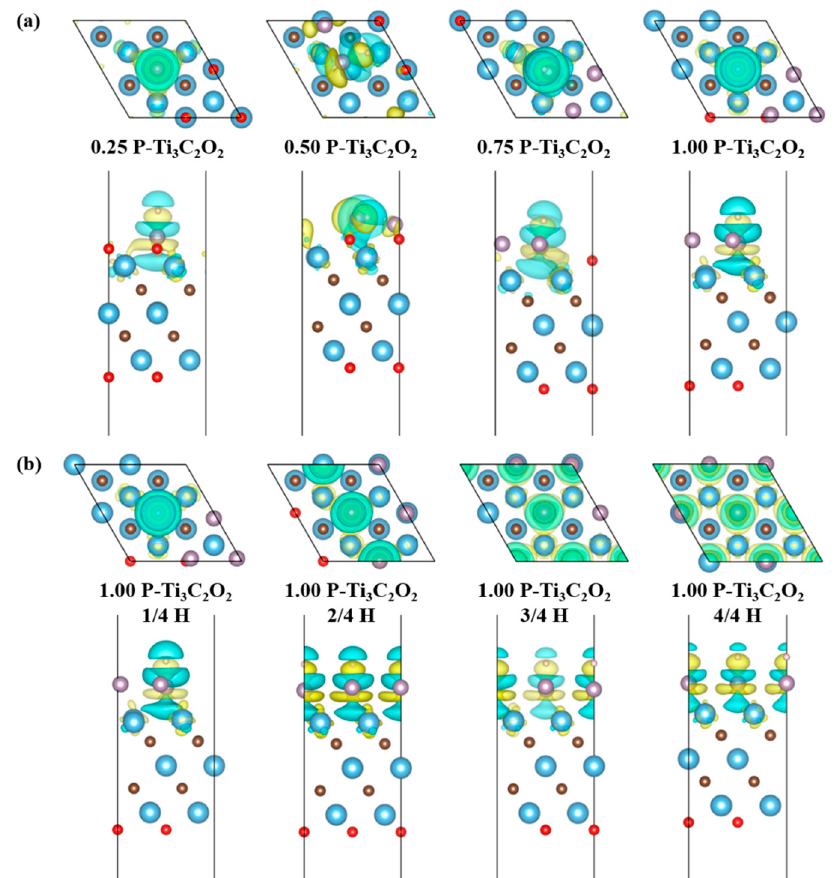
Figure 8. ( a ) The difference charge densities (DCD) of Ti 3 C 2 O 2 doping 0.25, 0.50, 0.75 and 1.00 concentrations of P element; ( b ) the DCD of Ti 3 C 2 O 2 doping 1.00 concentrations of P element at 1/4, 2/4, 3/4 and 4/4 H absorption concentrations. Warm color means gaining electrons, cold color means losing electrons.